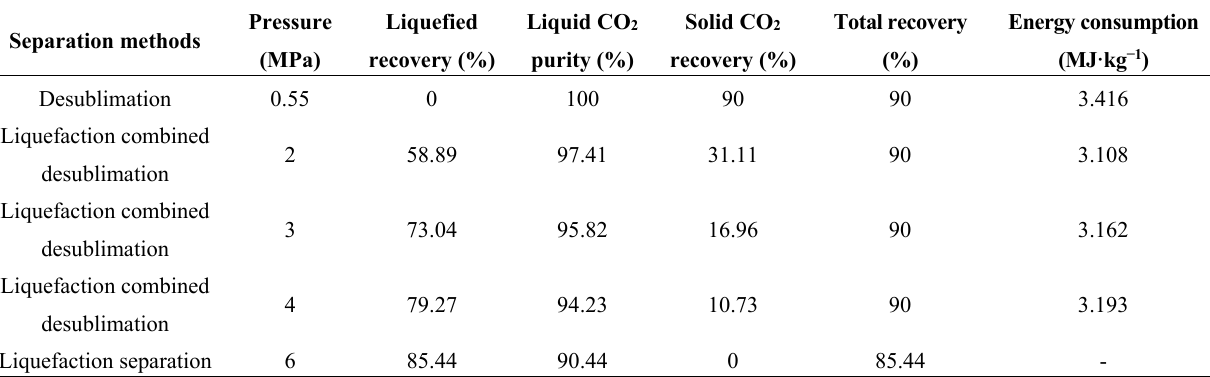
Table 6. Energy consumption comparisons of three separation